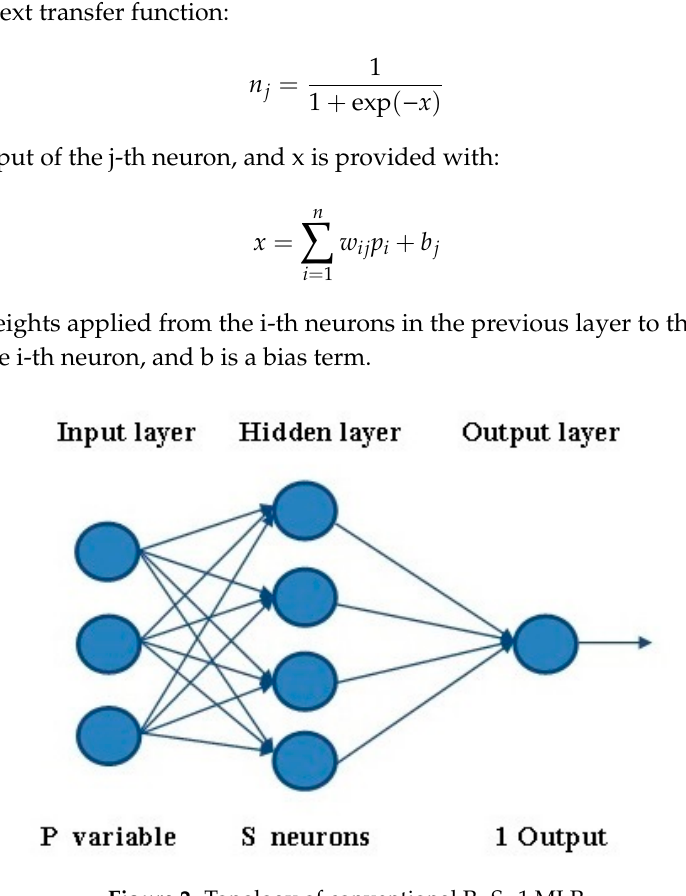
Figure 3. Block diagram of ANN based modeling.